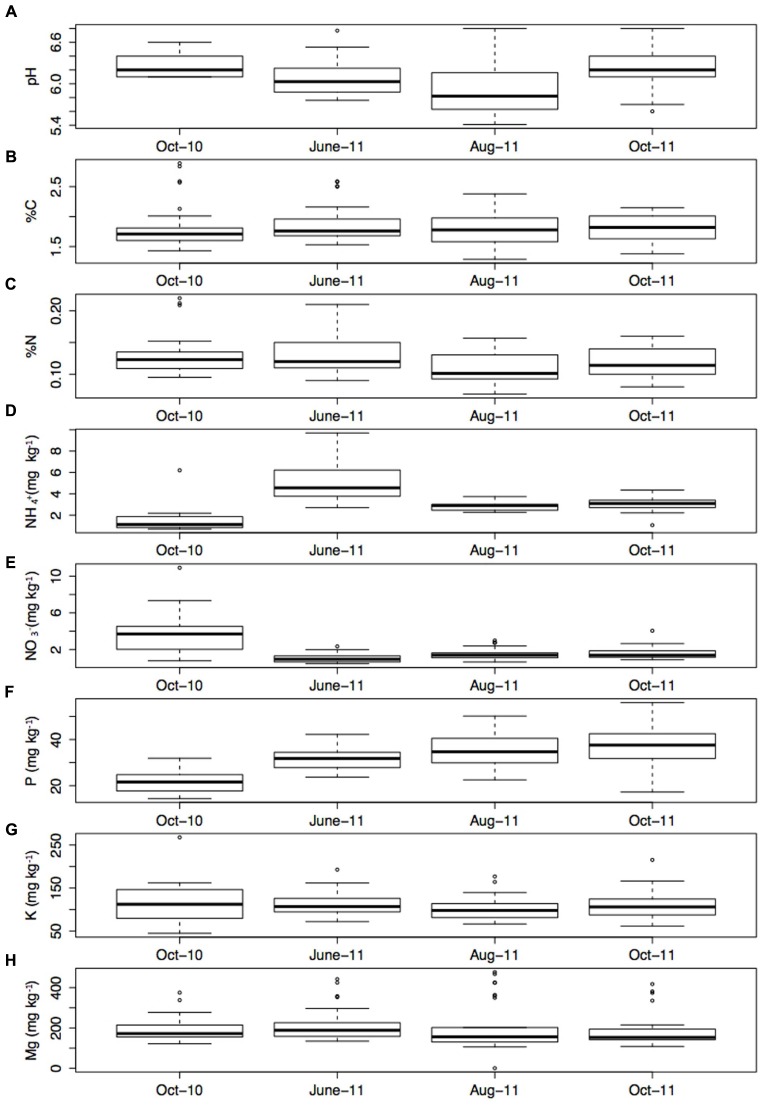
(A) pH, (B) % C, (C) % N, (D) NH4+ (mg kg-1), (E) NO3- (mg kg-1), (F) P (mg kg-1), (G) K (mg kg-1), and (H) Mg (mg kg-1) at each sampling time point (the mean of four sub samples). Error bars represent 1 standard error of the mean.